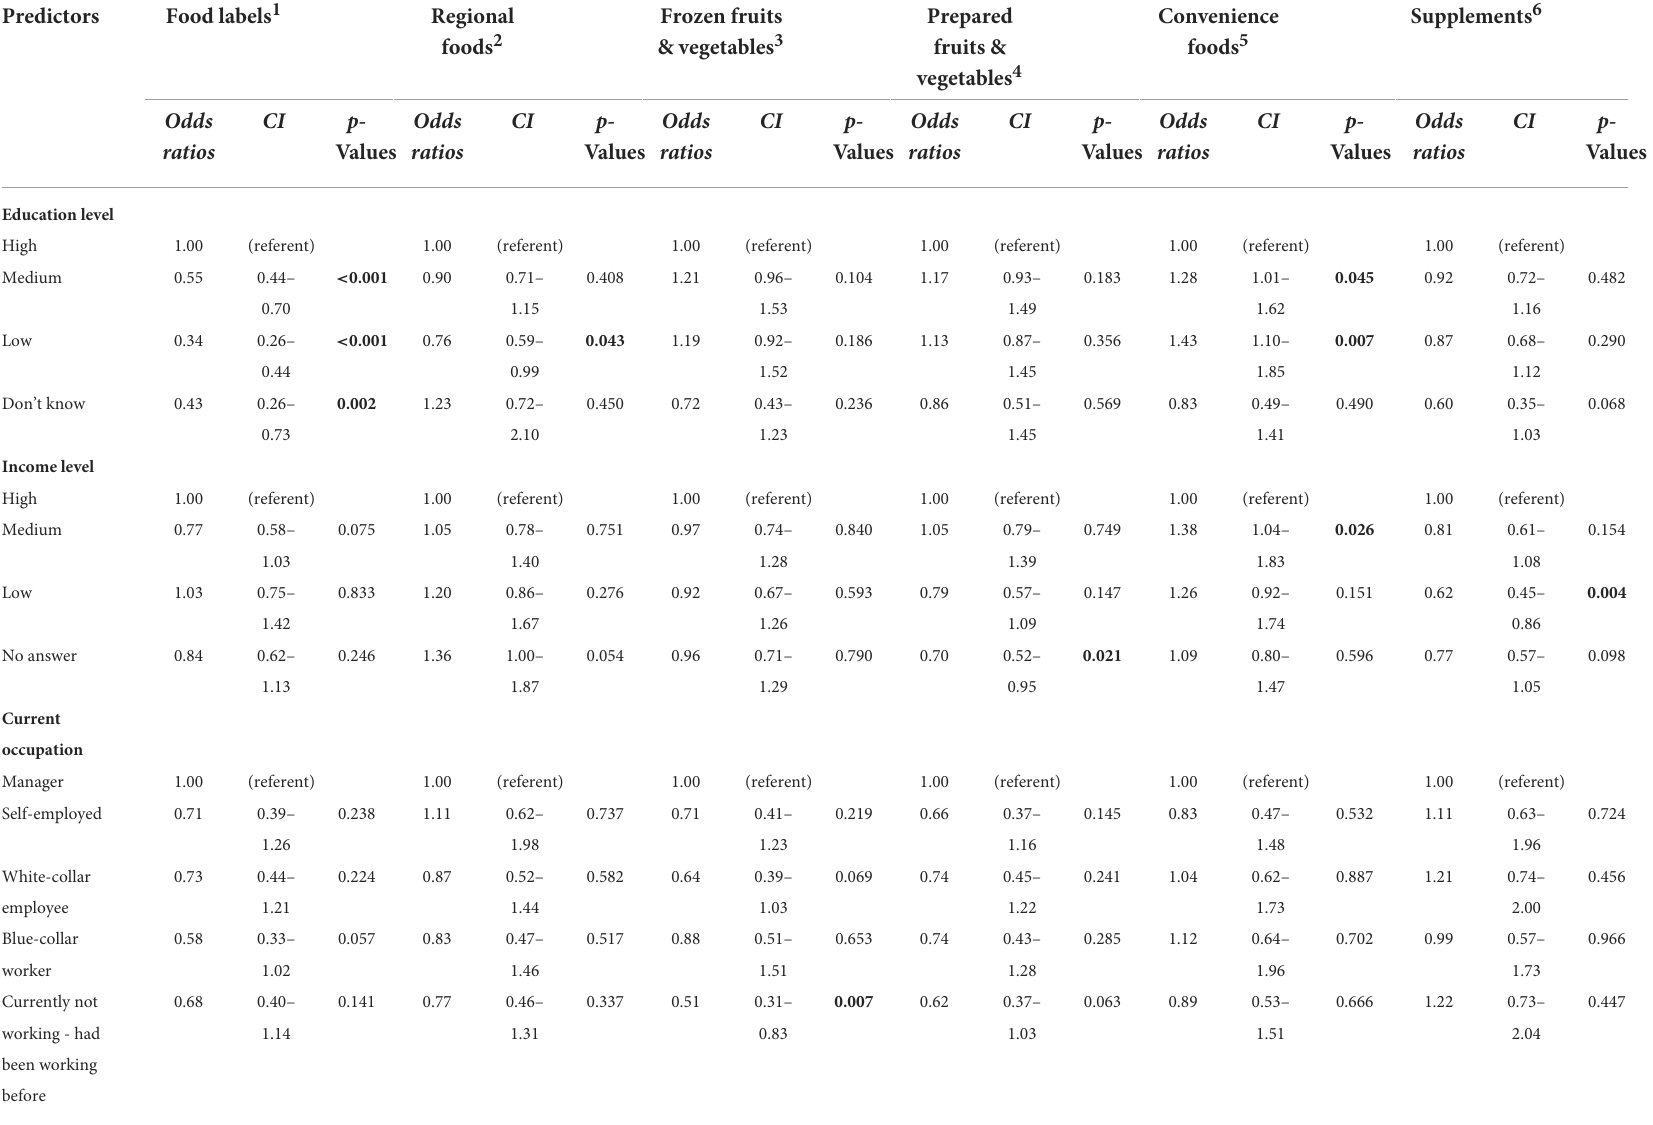
TABLE 2 Odds ratios, 95% confidence intervals and p -values for various food-related behaviors